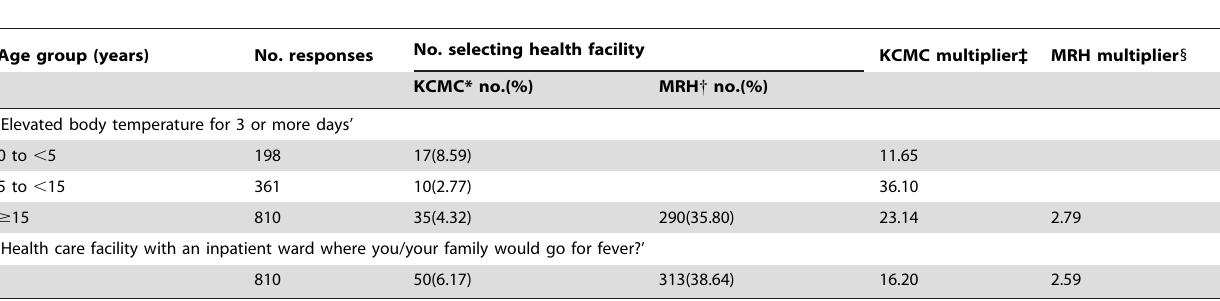
Table 2. Reported health care seeking behavior among household survey respondents and calculated multipliers, Moshi Urban and Moshi Rural Districts, Tanzania,